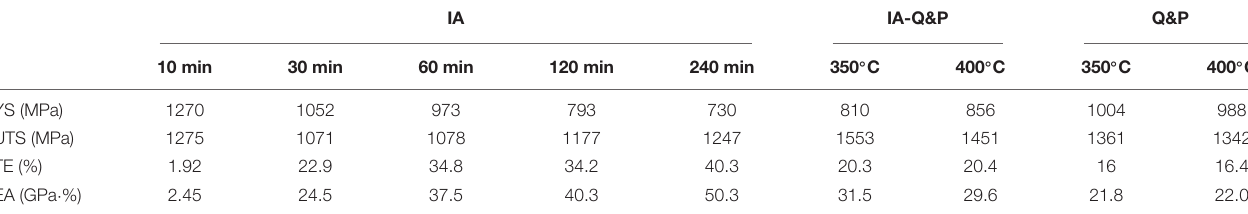
TABLE 1 | Mechanical properties of IA, IA-Q&P, and Q&P steels.